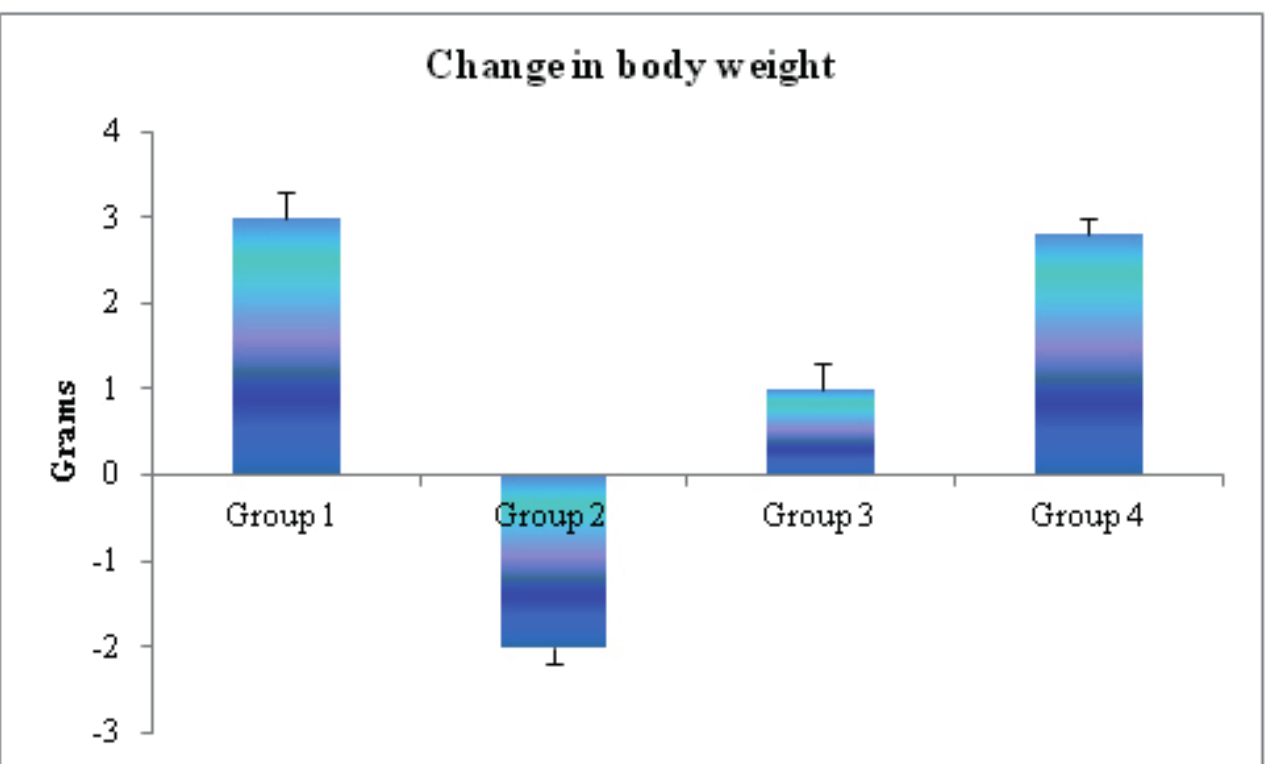
FIGURE 1 - Effect of β - carotene and Indomethacin on body weight of MSU crystal- induced arthritis N=6 animals in each group. The values are expressed as mean ± S.D. Comparisons indicated by lower case letters were made as follows: a – group I vs. group II, III and IV; b – group II vs. group III and IV; c – group III vs. group IV. Statistical analysis was carried out by one way ANOVA followed by Student’s Newman – Kuel’s